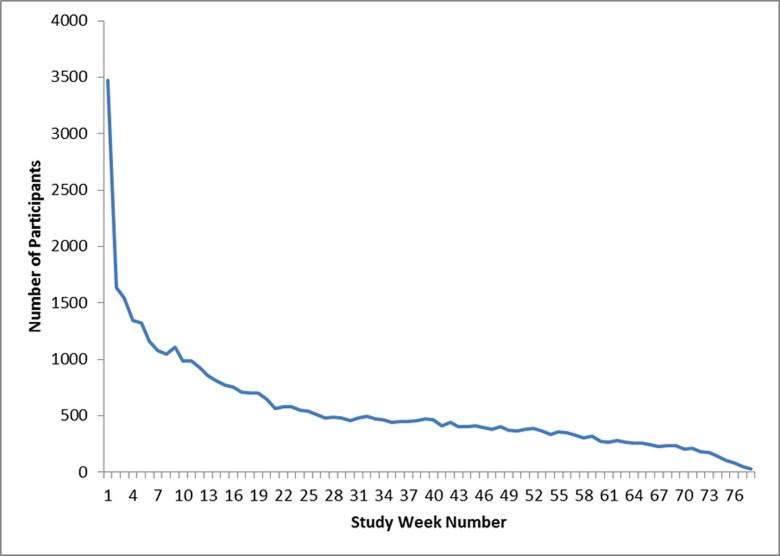
Total number of participants using the device over time (by study week number).Week 1 on the x-axis refers to the participant’s first week of using the device. The y-axis indicates the number of participants recordings at least one use of the device during each week they were in the study.